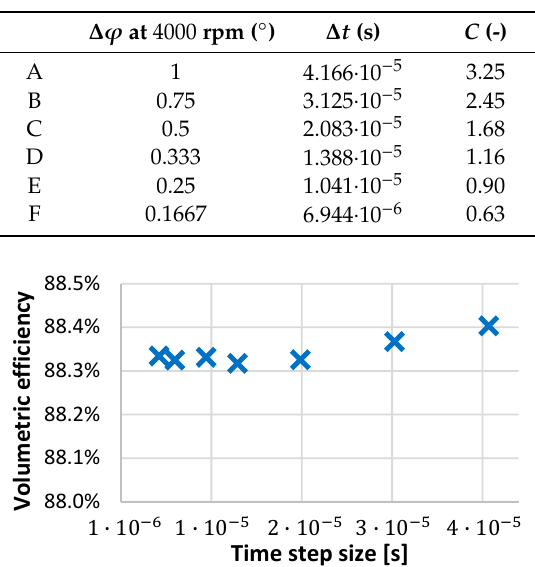
Figure 12. Time step influence on the volumetric efficiency.